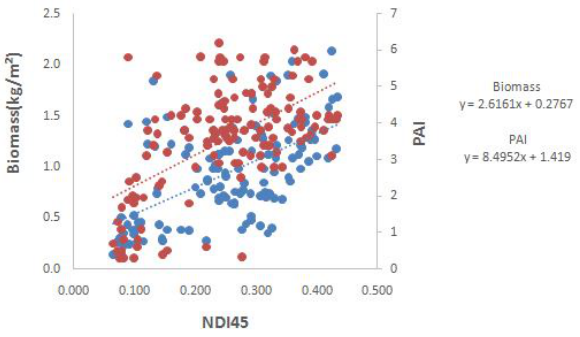
Figure 11. Statistical analysis of NDI45 with PAI and